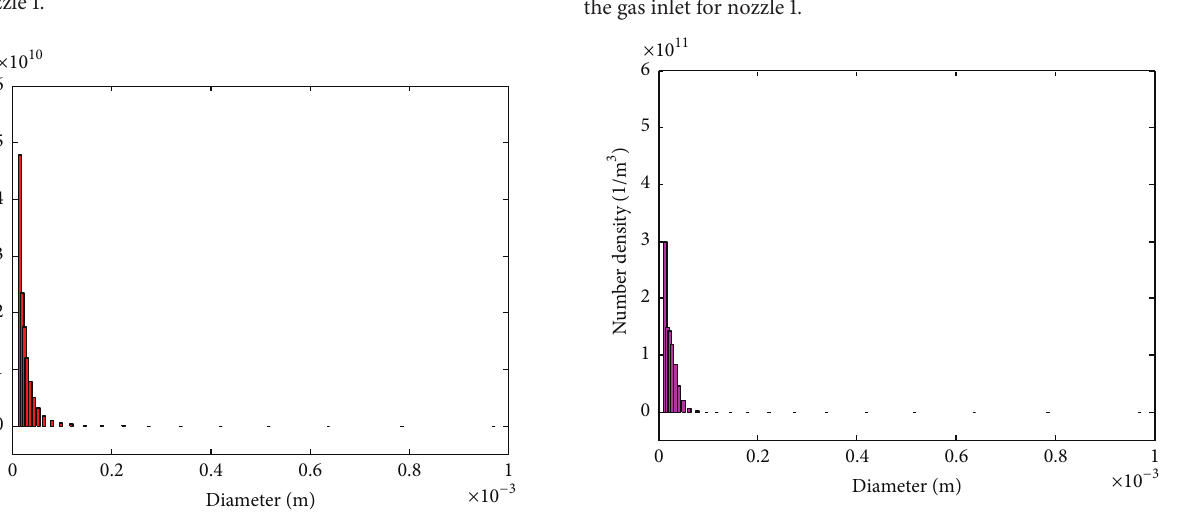
Figure 16: Plot of the number density of bubble in the entire volume for nozzle 3.